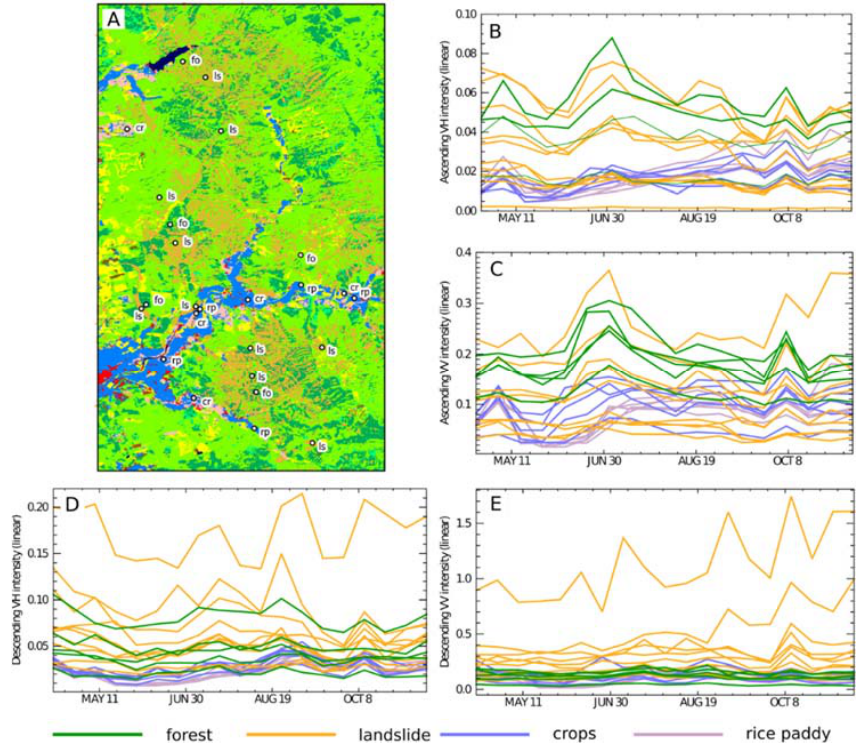
Figure 8. Temporal changes in the intensity of landslide (ls, orange), forest (fo, green), crop field (cr, pink) and rice paddy (rp, blue) samples. (Top left map contains the location of the samples.) ( A ) = LULC map of the site (see Figures 1 and 3 for legend); ( B – E ) = intensity time series: ( B ) = VH, as ‐ cending geometry; ( C ) = VV, ascending geometry; ( D ) = VH, descending geometry; ( E ) = VV, de ‐ scending geometry